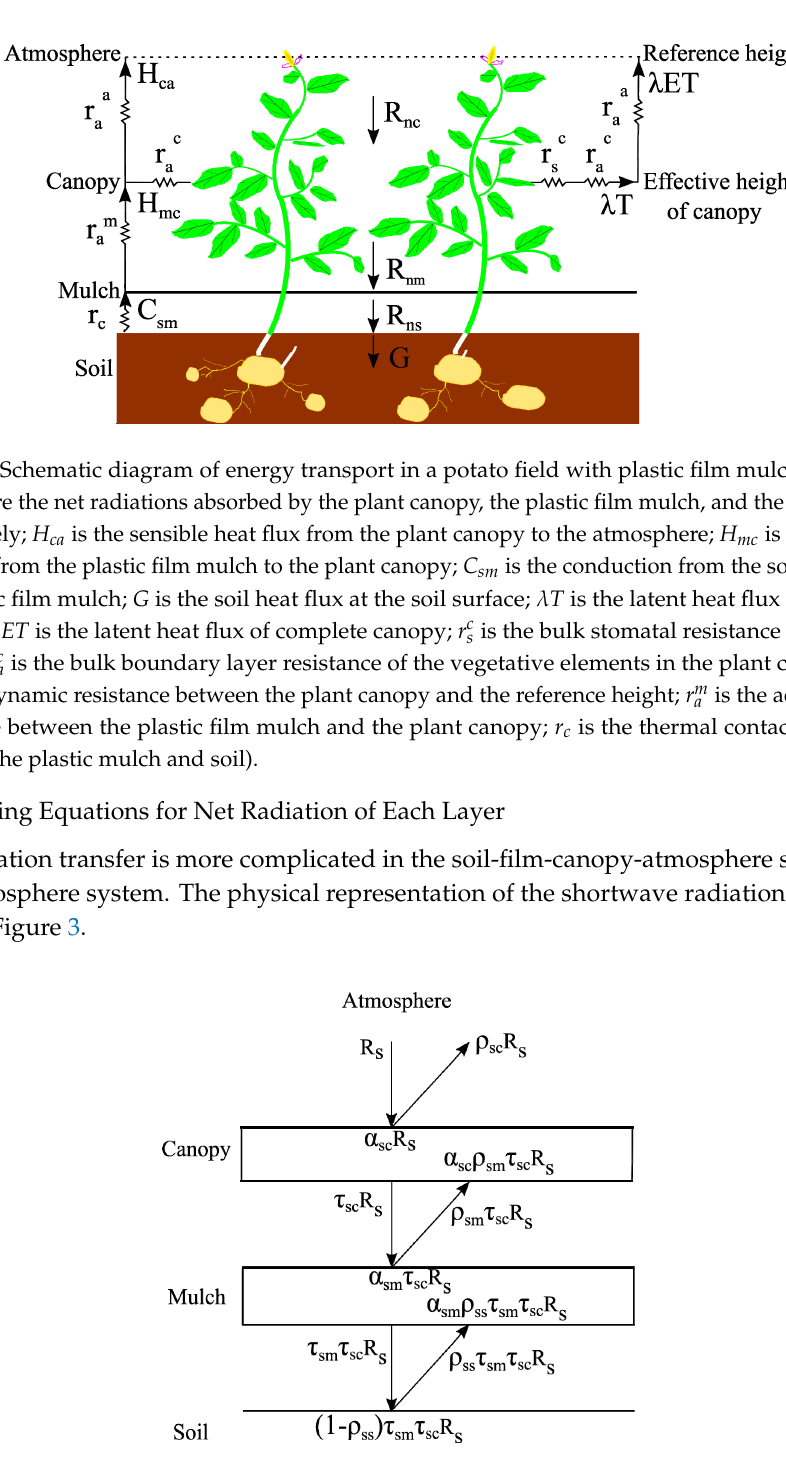
Figure 3. Schematic diagram of shortwave radiation transfer in the potato canopy, plastic film mulch, and soil surface ( R s is the global radiation; α sc and α sm are the shortwave absorptances of the plant canopy and plastic film mulch, respectively; ρ sm and ρ ss are the shortwave reflectances of the plastic film mulch and soil, respectively; and τ sc and τ sm are the shortwave transmittances of the plant canopy and plastic film mulch, respectively).